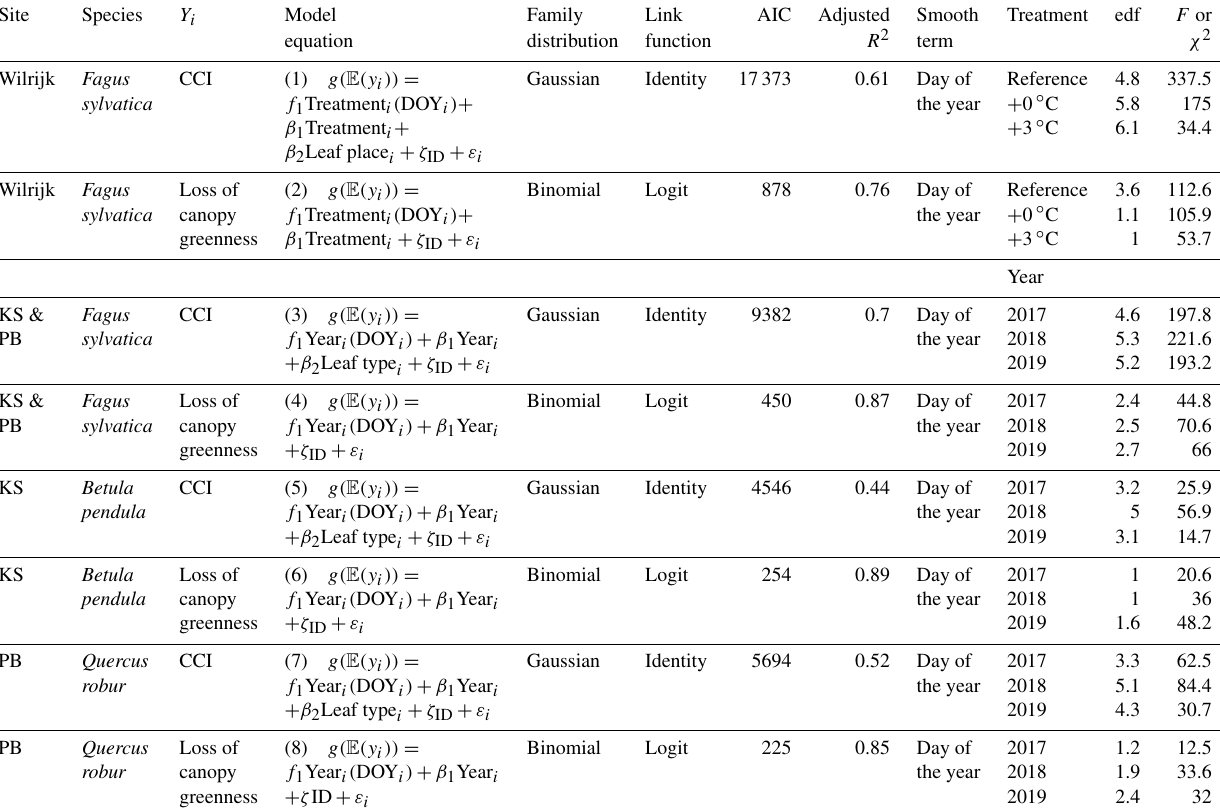
Table 2. Adjusted R 2 , effective degrees of freedom (edf’s) and F -test values of the GAMM smooth terms (day of the year). All smooth terms were significant, with P values < 0 . 001. E (y i ) values are the expected values of the response variable y i ; f (x i ) is the smooth function of the covariate x i ; β i is the intercept of the covariate x i ; ζ is the random effect, and ε i values are the errors. All smooth functions were fitted using P-splines. The chlorophyll content index, day of the year and tree individual are abbreviated by CCI, DOY and ID,